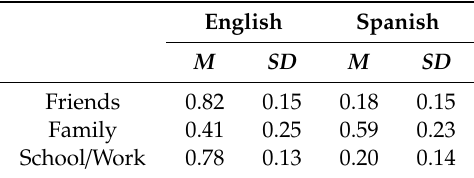
Table 1. Mean percent of language use by domain.